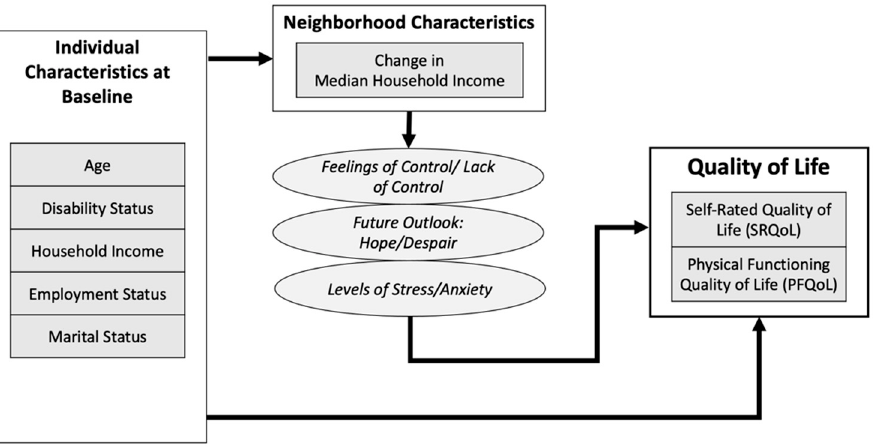
Figure 1. Logic model for relationships between neighborhood change and quality of life outcomes.